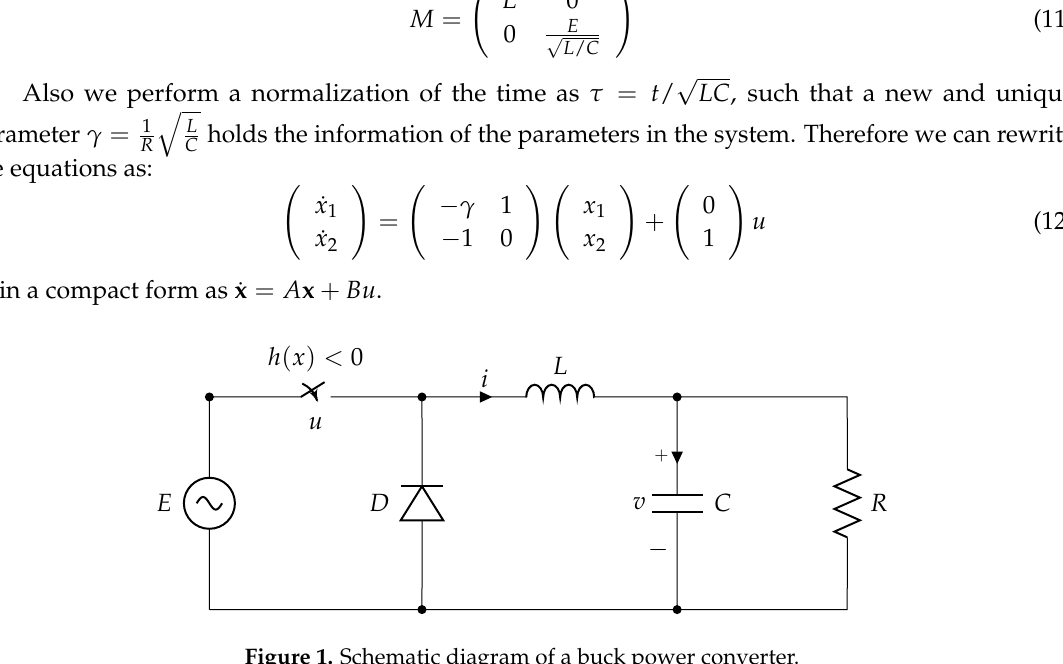
Figure 1. Schematic diagram of a buck power